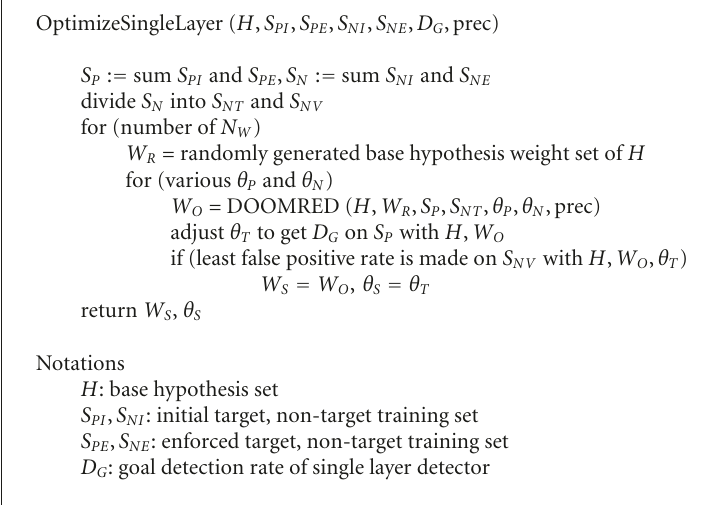
at each single layer detector while showing good